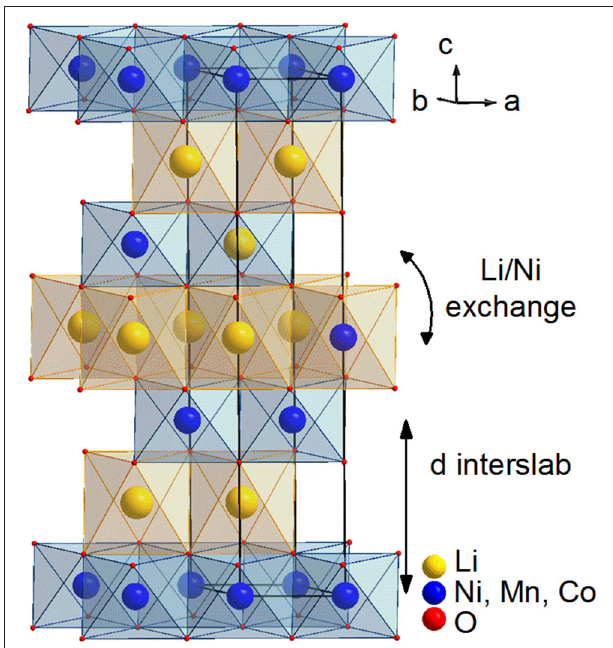
FIGURE 4 | Layered structure of the Li(Ni 0.6 Mn 0.2 Co 0.2 )O 2 pristine material.